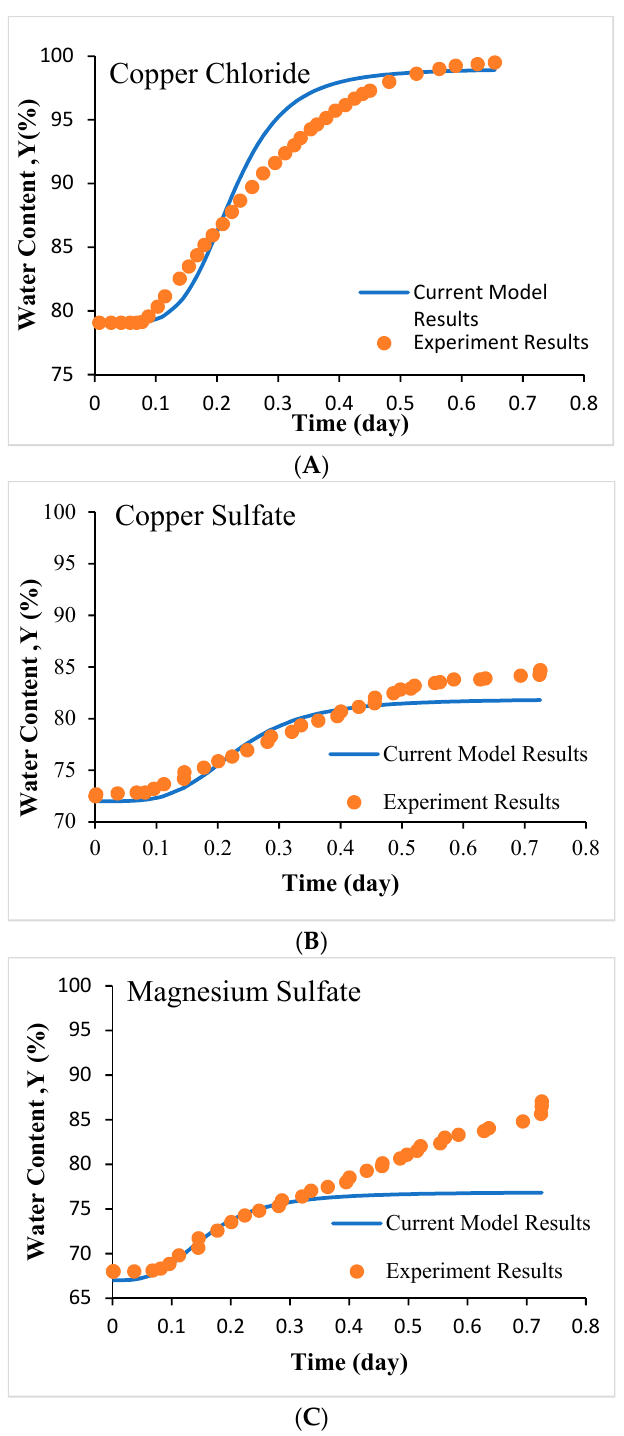
Figure 3. Comparison between the computed water contents against the experimental data using the static relative humidities (RHs) of ( A ) copper chloride, ( B ) copper sulfate, and ( C ) magnesium sulfate [18].